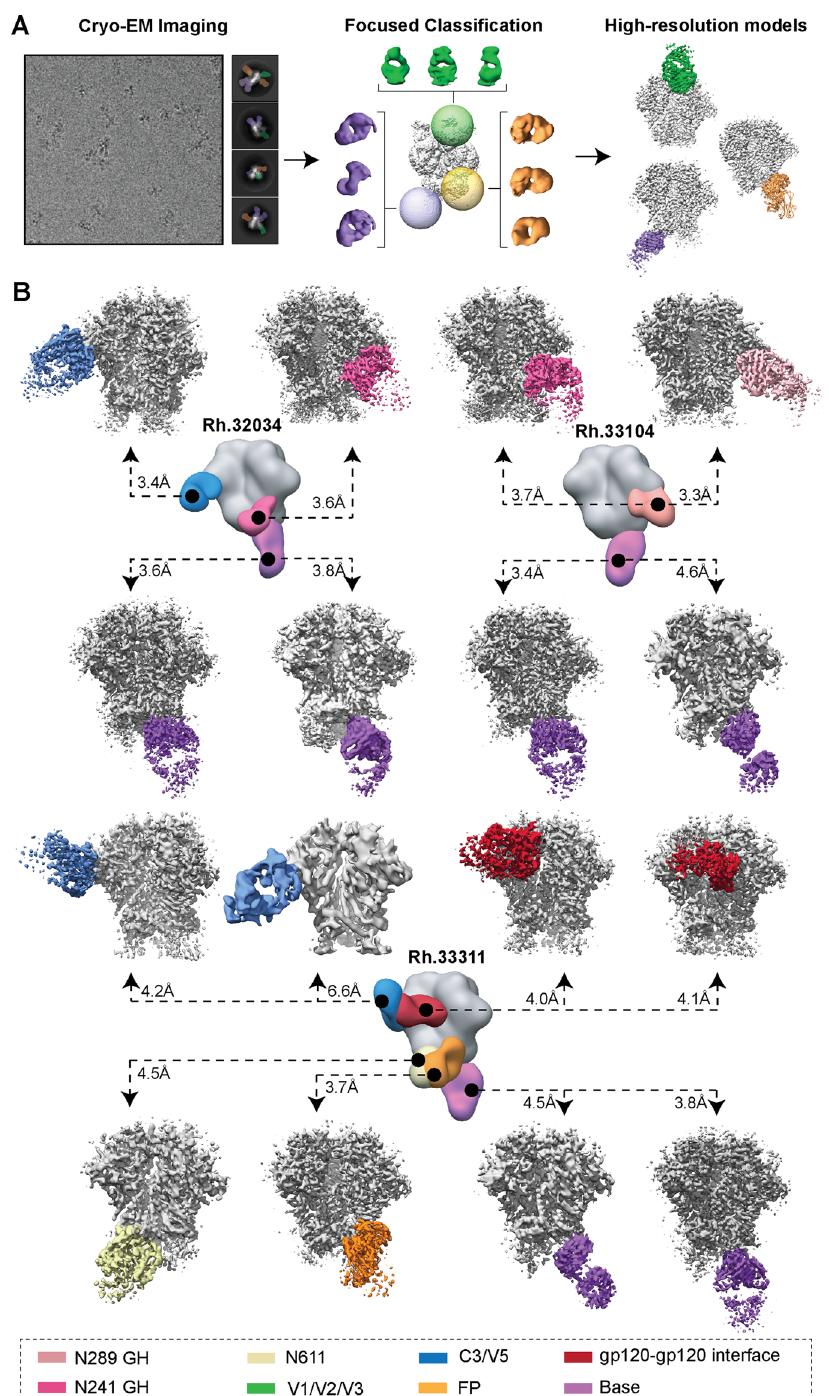
Fig. 2 CryoEMPEM analysis of polyclonal antibodies elicited by BG505 SOSIP trimer immunogens. A Schematic illustration of the data processing work fl ow of cryoEMPEM. B CryoEMPEM analysis of immune complexes generated using polyclonal Fabs isolated from plasma samples from animals Rh.32034 (top left), Rh.33104 (top right), and Rh.33311 (bottom). High-resolution trimer-Fab complexes featuring structurally unique antibody speci fi cities detected in cryoEM datasets are shown in the corresponding panels. BG505 SOSIP antigen is represented in gray and Fab densities are colored according to the legend shown at the bottom. In the center of each panel is a composite fi gure from nsEMPEM. The apparent resolution of each reconstructed cryoEM map is